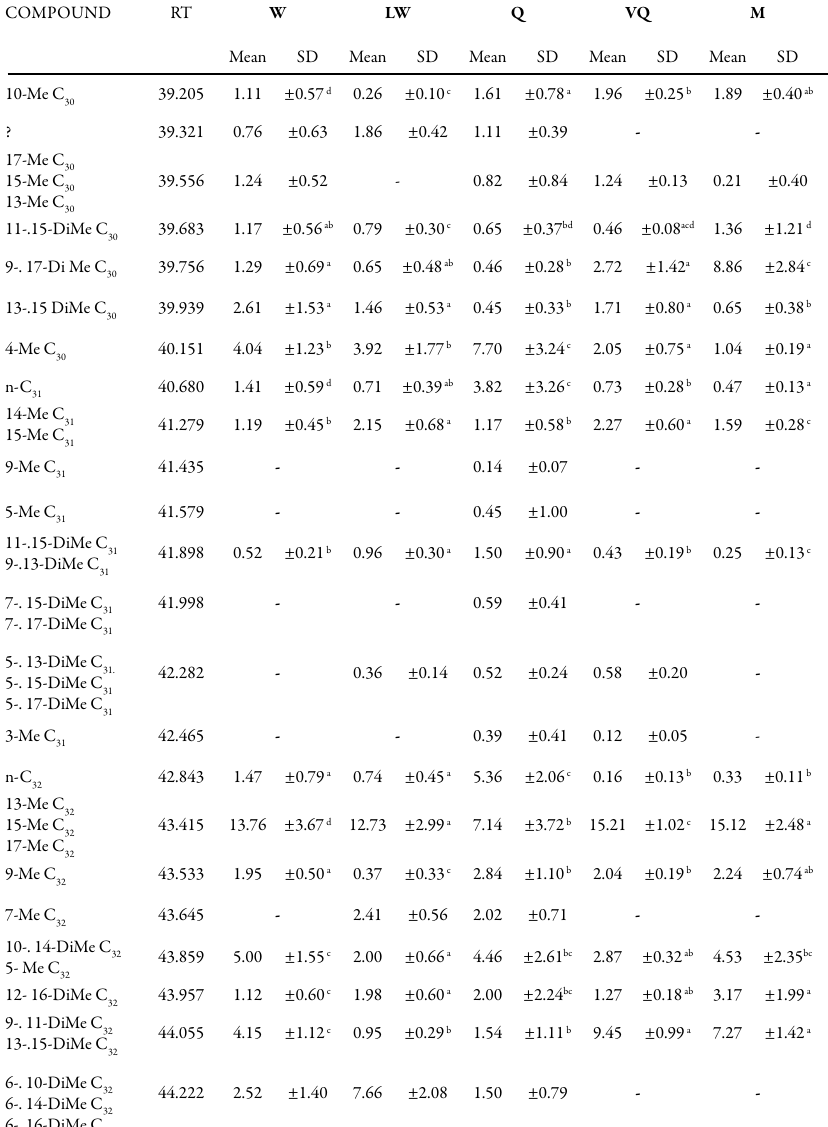
Table 1 (continued): Cuticular hydrocarbons present in the Camponotus textor workers (W), major workers (LW), queens (Q), virgin queens (VQ) and males (M). rT = retention time in minutes. dif- ferent letters indicate significant differences